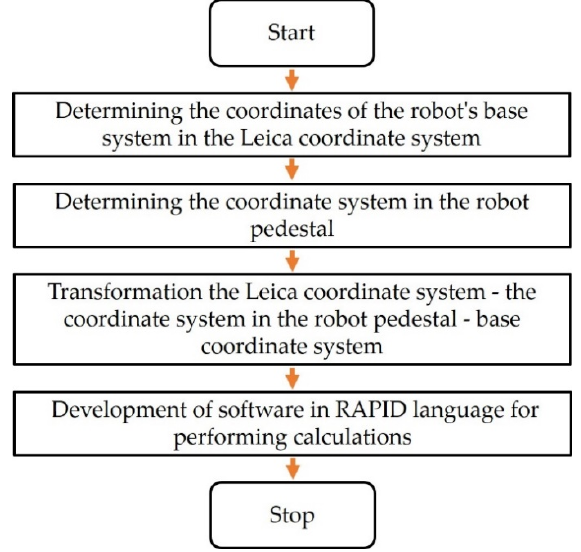
Figure 5. The proposed algorithm of the robot programming process.